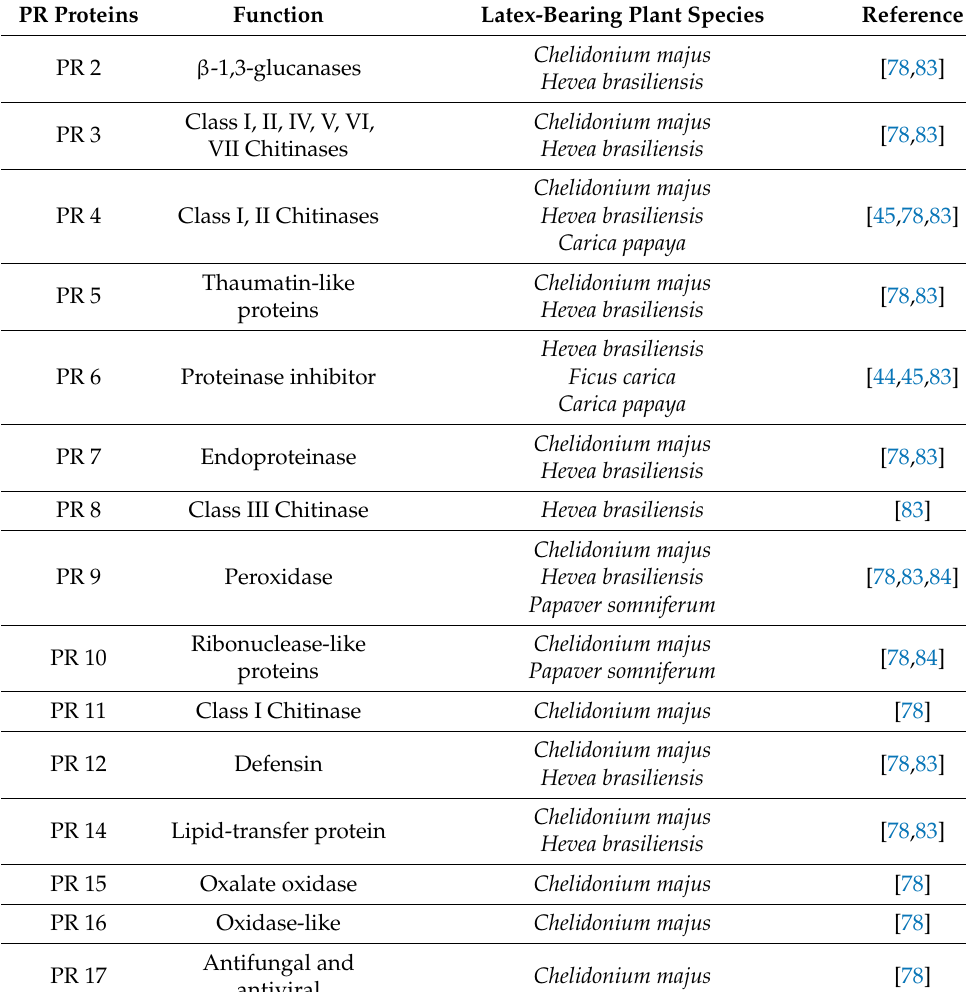
Table 1. Summary of PR proteins previously identified in latex-bearing